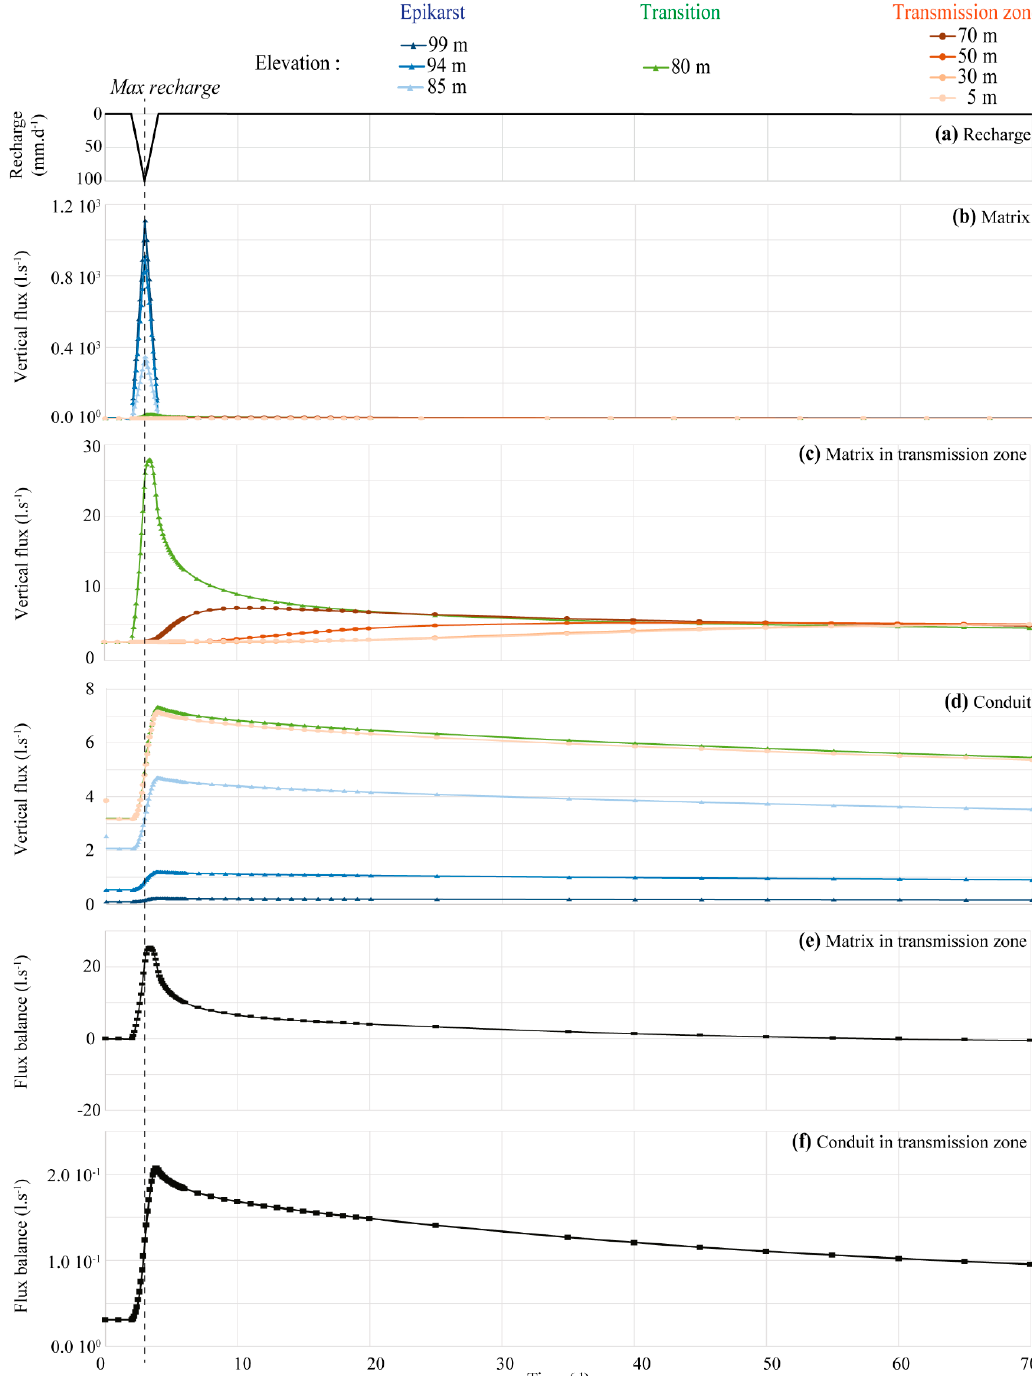
Figure 3. Vertical flux through horizontal planes at different elevations and mass balances, in the matrix and conduit respectively, as functions of time. ( a ) Recharge at the top of the model ( b ) Flux through a horizontal matrix section at different elevations in both the epikarst and transmission zone. ( c ) Flux through a horizontal matrix section at different elevations in the transmission zone only with an adapted scale. ( d ) Flux through a horizontal conduit section at different elevations in both the epikarst and transmission zone. ( e ) Flux balance of matrix in the transmission zone. ( f ) Flux balance of a conduit in the transmission zone.